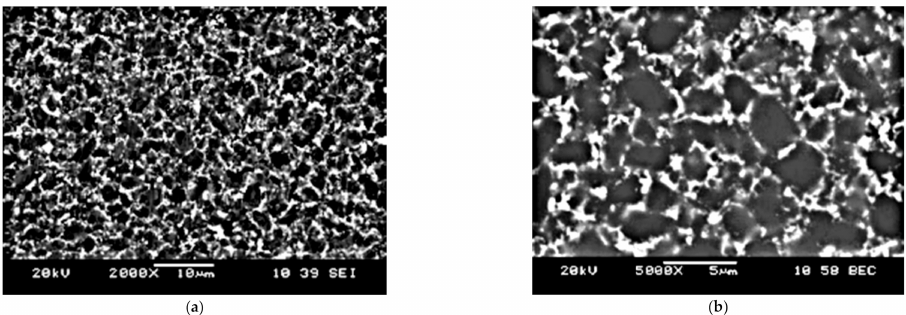
Figure 4. SEM micrograph of the CBN tool: ( a ) magnification 2000 × , ( b ) magnification 5000 ×